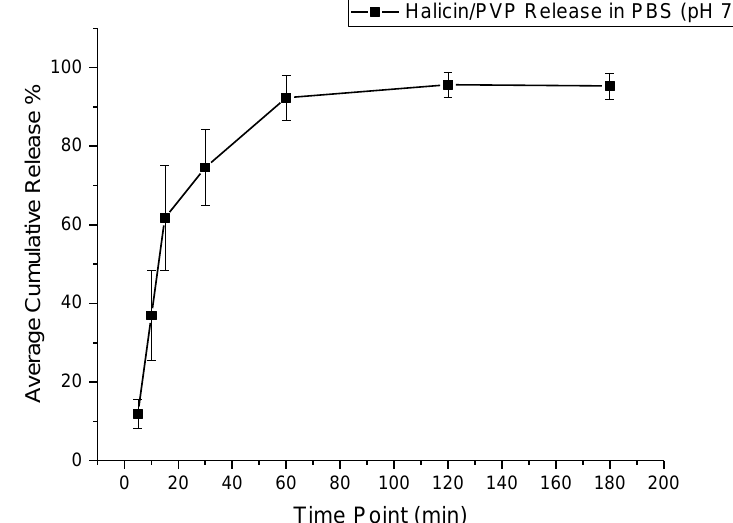
Figure 7. Cumulative release profile of the drug-loaded fibers showing a burst release of the drug (~60%) after 15 min and a full drug release after 120 min.